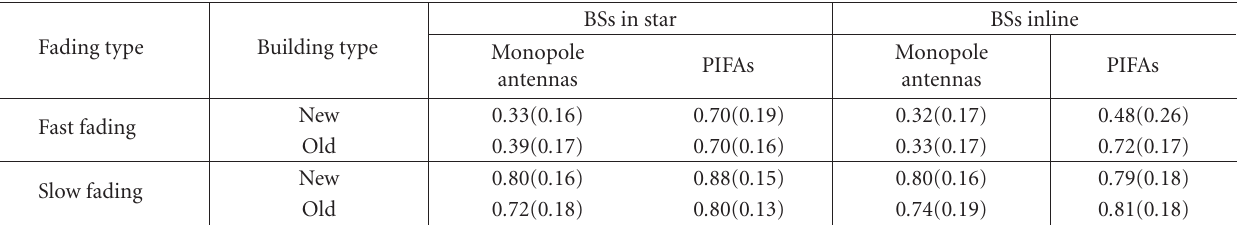
Table 3: Indoor antenna branch correlations for diverse situations. Given are the averages of the magnitudes of the complex correlation coe ffi cients, standard deviations of the magnitudes in